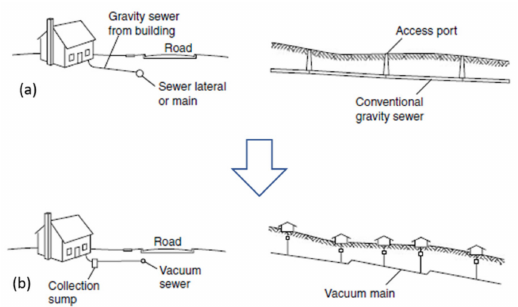
Figure 3. Wastewater collection systems: ( a ) conventional gravity flow system; ( b ) vacuum collection [17].